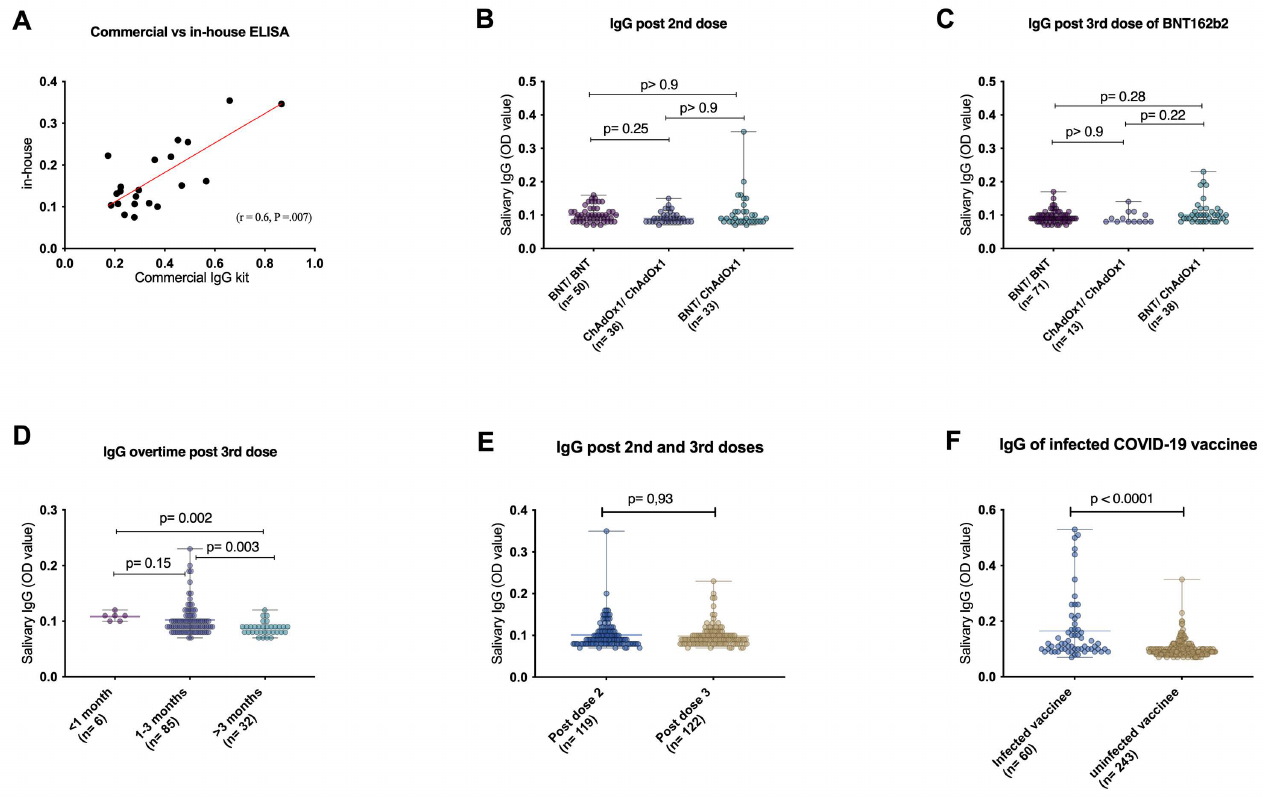
Figure 1. Comparisons between a commercial and the in-house ELISA were performed using a panel of 21 saliva samples ( A ) to validate anti-SARS-CoV-2 spike protein IgG in-house assay performance in saliva. The vaccine-induced antibodies against SARS-CoV-2 Spike-protien between different vaccine types after 2nd dose ( B ) and 3rd dose ( C ) were evaluated in non-infected COVID-19 individuals. Salivary IgG levelsafter BNT booster (cohort 2) were grouped based on time since the 3rd dose into (1) less than 1 month, (2) 1–3 months, and (3) more than 3 months ( D ). The levels of salivary IgG before and after the BNT booster dose ( E ) and between previously COVID-19 infected individuals and non-infected individuals ( F ) were compared. A nonparametric Mann–Whitney U test for significance was performed. BNT, BNT162b2 vaccine. ChAdOx1, ChAdOx1 nCoV-19